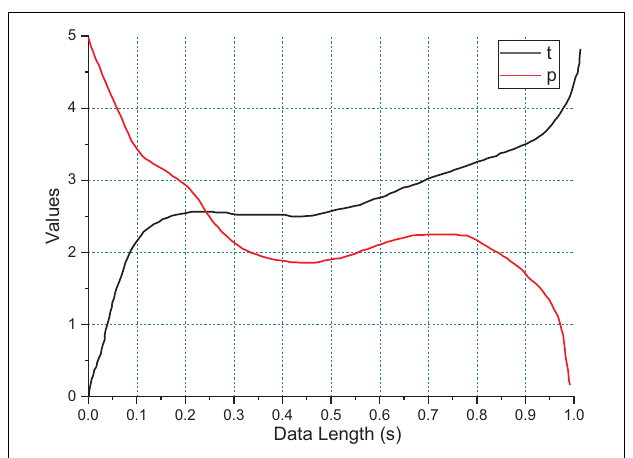
FIGURE 8 | Results of paired t -test for difference in online recognition correctness for different data